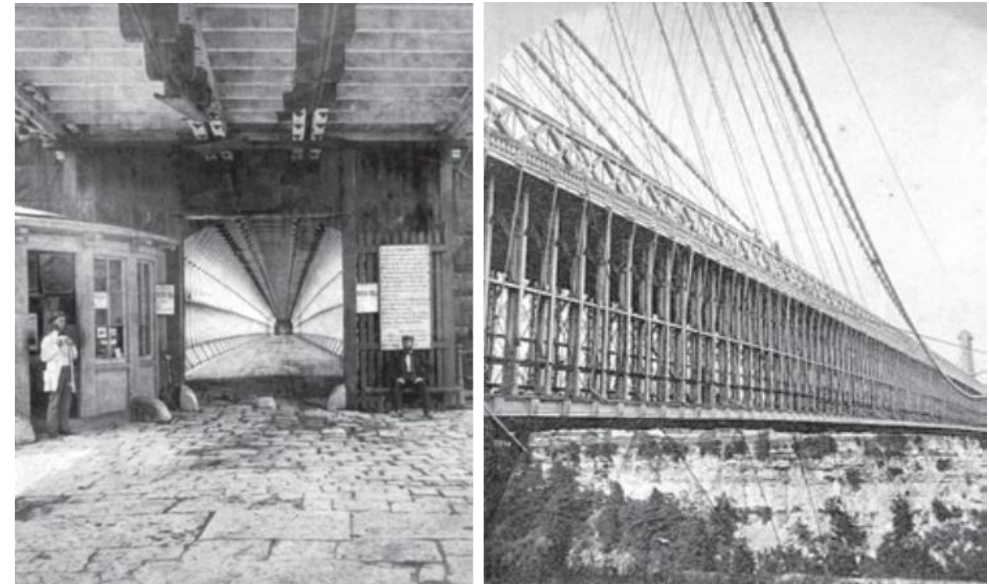
Figure 21. Bridge over Niagara Falls. General view of the structure and view from the pedestrian access, where the “ box beam ” can be seen. Designed by J.A. Roebling, United States, 1851. Source: Photo: Eric De Lony Collection.